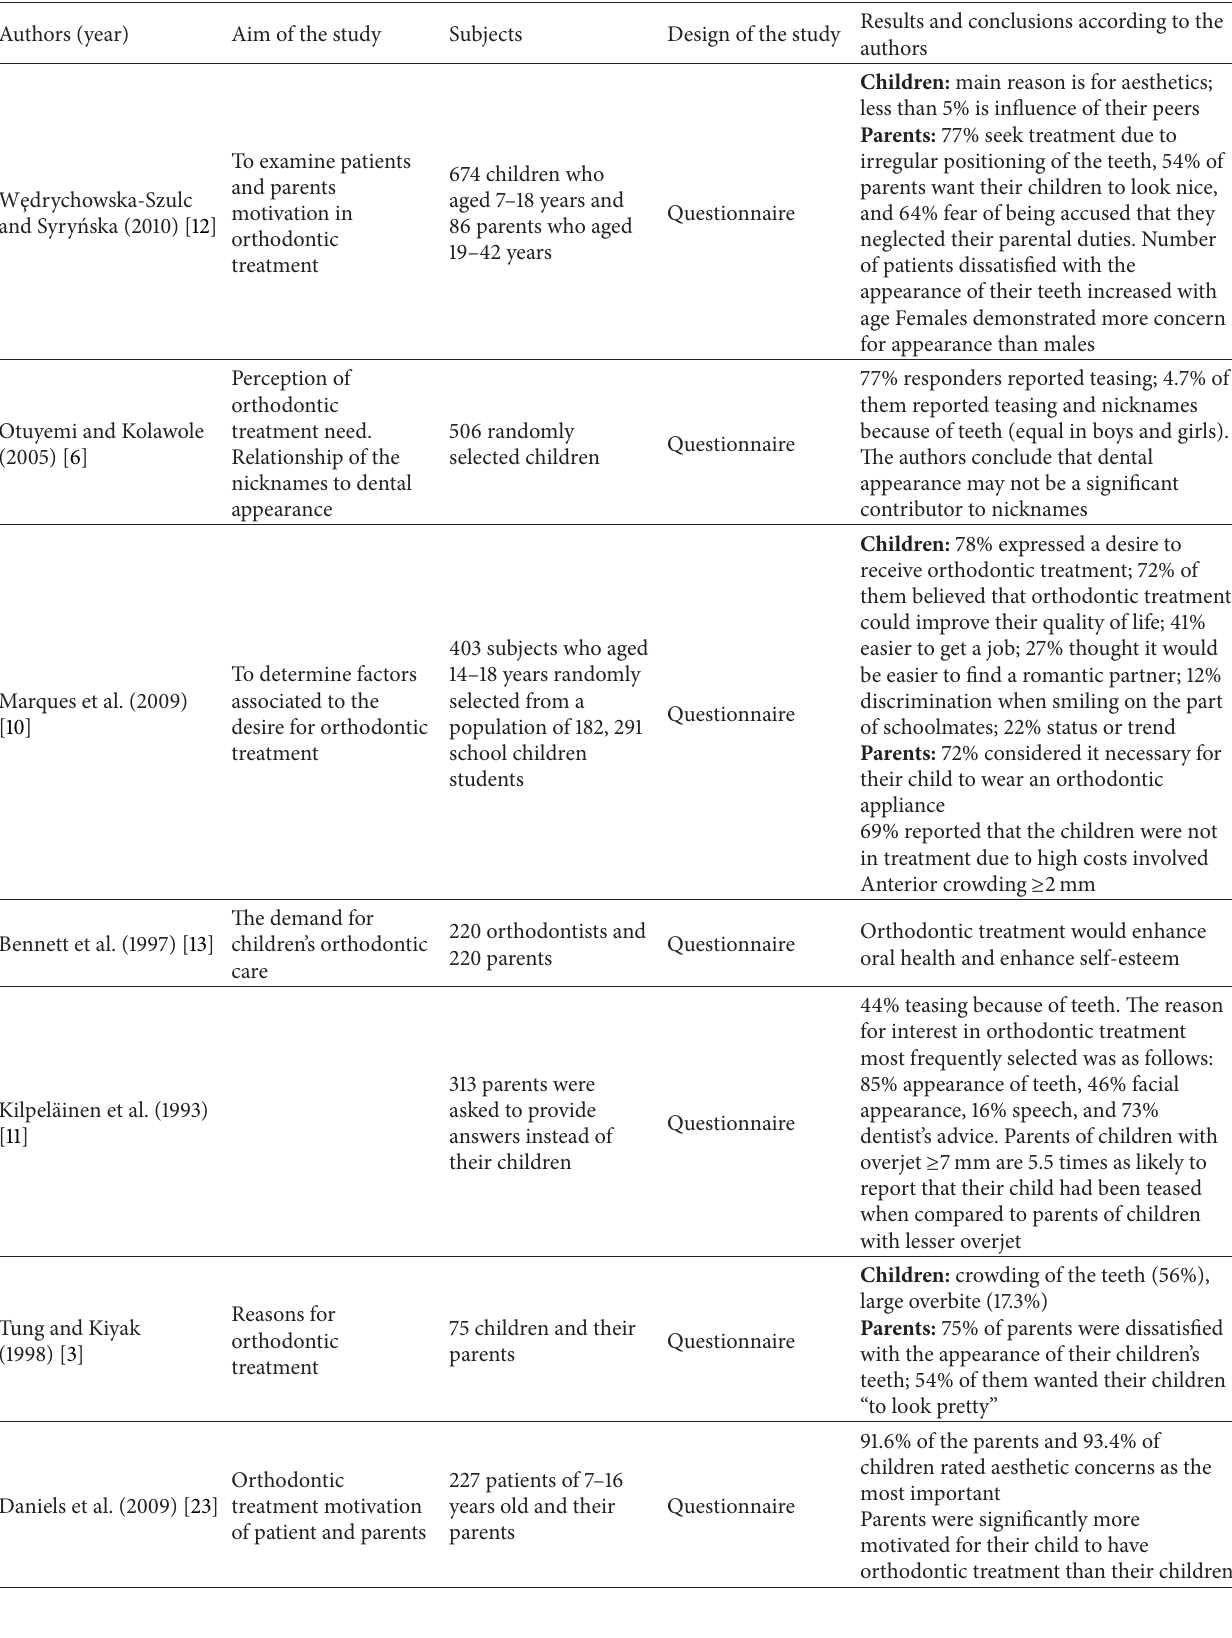
Table 1: Publications related to motivational factors in orthodontic treatment used for systematic review analysis. Authors